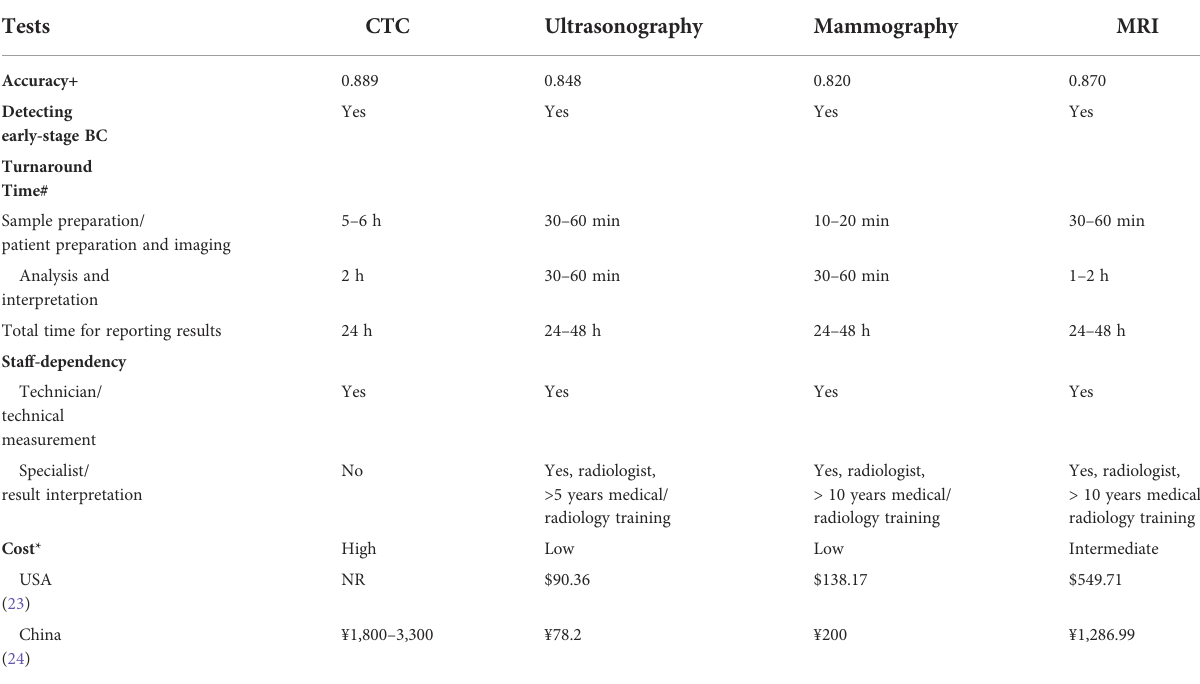
TABLE 6 Strengths and weaknesses of CTC and imaging